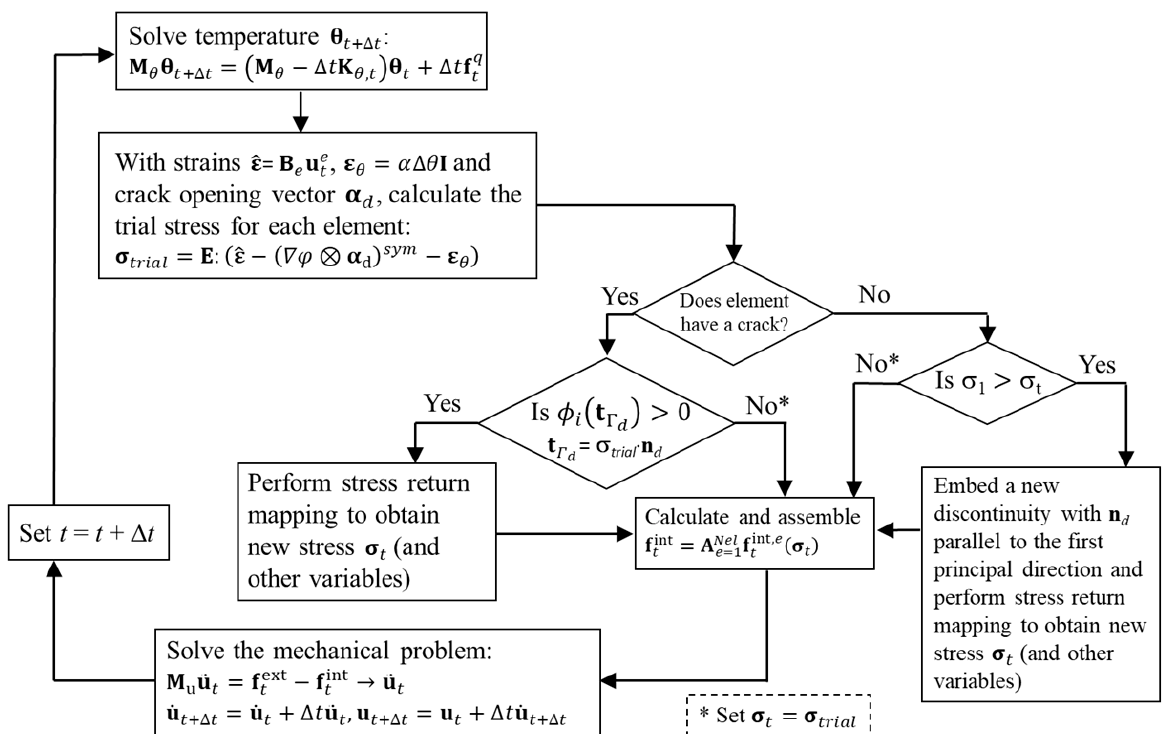
Figure 2. The flowchart of the global solution of the thermo-mechanical problem. The equation in Figure 2 for solving the temperature and the mechanical